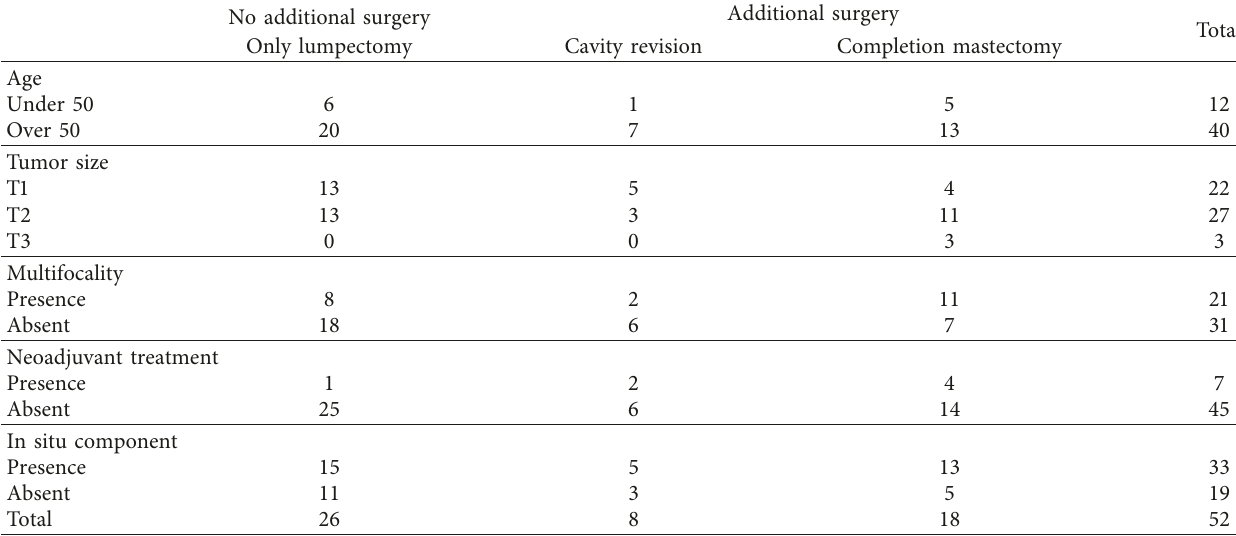
Table 2: Clinicopathological features of patients who underwent